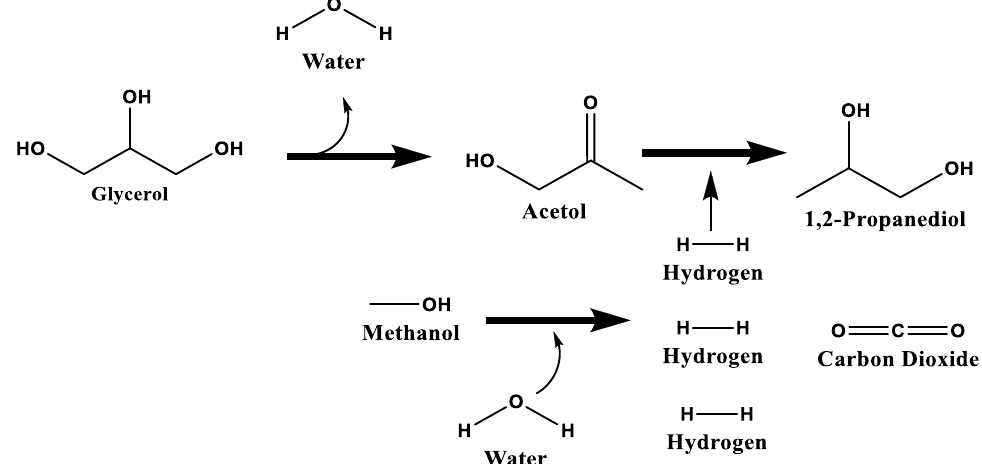
Figure 1. Reaction pathway of glycerol hydrogenolysis process using in situ hydrogen produced from methanol steam reforming.